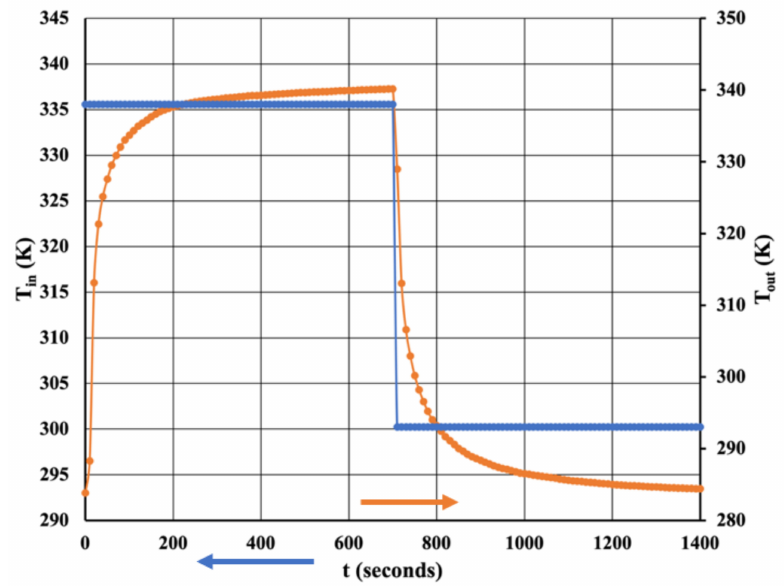
Figure 6. Applied inlet temperature with